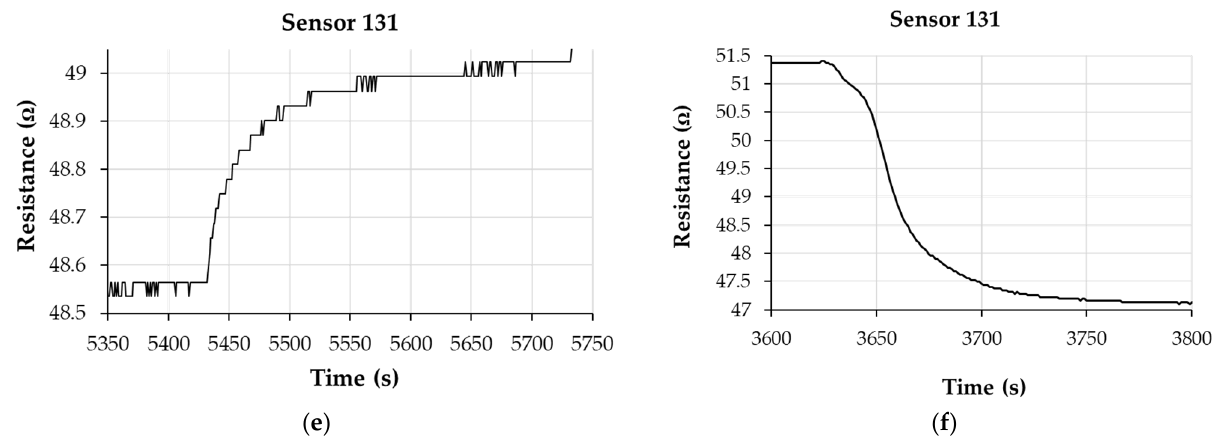
Figure 16. The response and recovery times of the chemiresistive 111, 121, and 131 humidity sensors with sensing films kept at room temperature where ( a ) is the response time and ( b ) is the recovery time for sensor 111; ( c ) is the response time and ( d ) is the recovery time for sensors 121; ( e ) is the response time and ( f ) is the recovery time for sensor 131. Response time was measured for the case when relative humidity was increased from 40% to 50%, while the recovery time was measured from 100% to 0% RH (clean dry nitrogen).